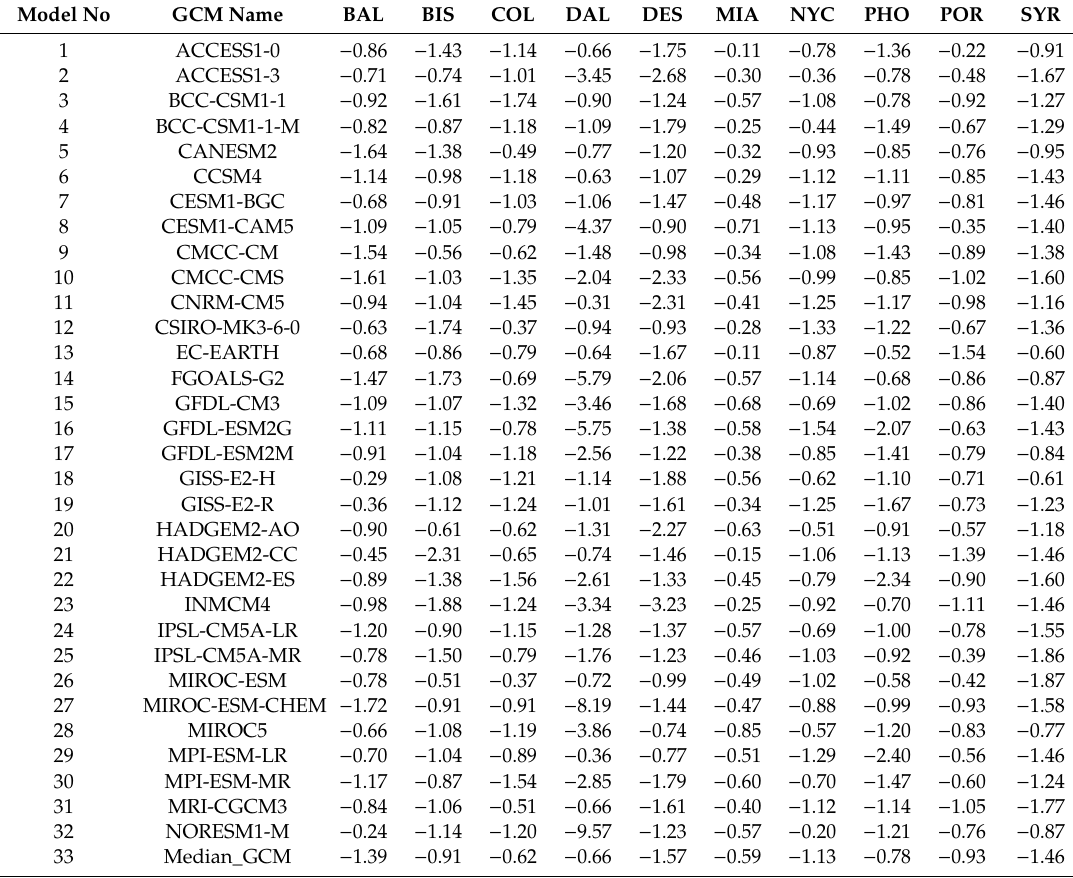
Table A11. NSE coe ffi cient of First between observed and simulated data